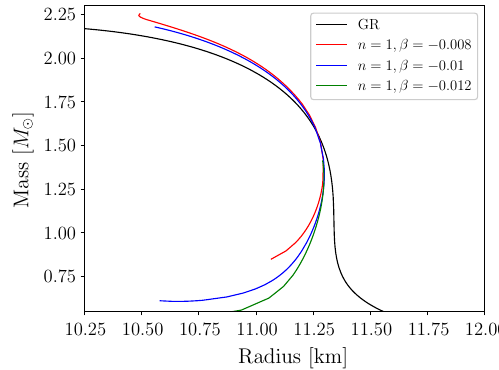
Fig. 2 Mass-radius relations for the APR4 EOS and different values of β for the coupling function (12). Only n = 1 stable solutions exist for this coupling